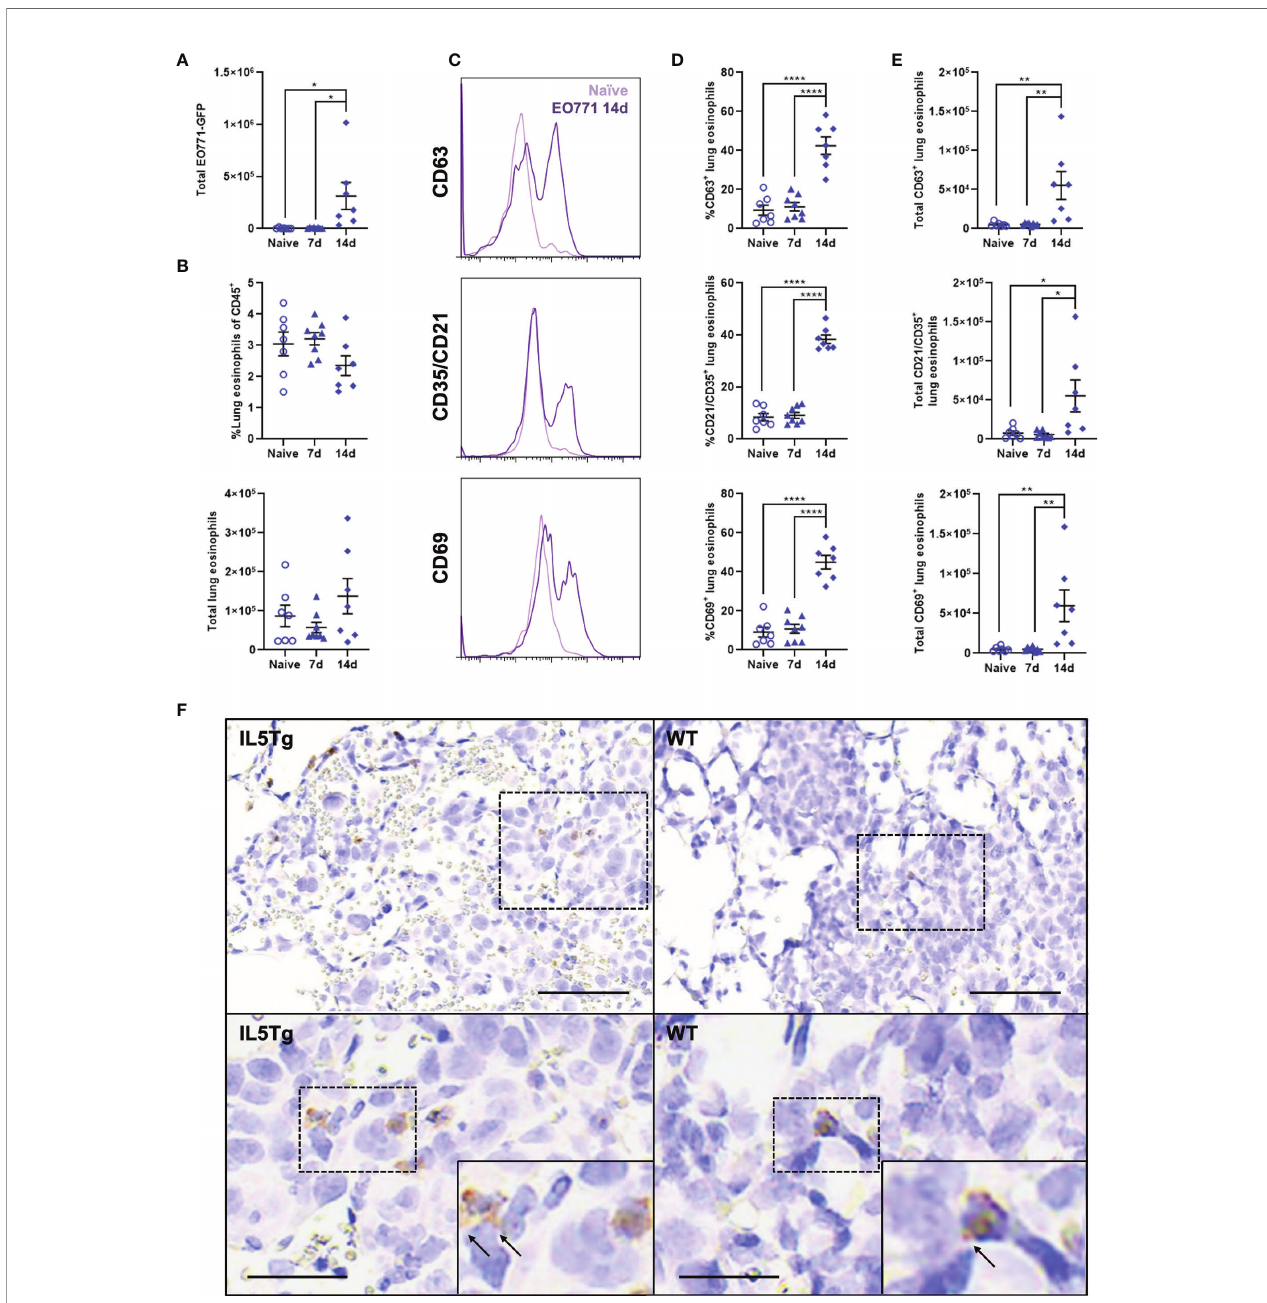
FIGURE 4 | Lung eosinophils become activated during pulmonary EO771 tumor growth. (A) Total number of EO771-GFP cells in the lungs of WT mice 7 days and 14 days following i.v. injection of EO771-GFP cells. (B) Frequency and total number of lung eosinophils in naïve WT mice and WT mice injected i.v. with EO771-GFP cells 7 days and 14 days post-injection. (C) Representative histogram overlays of eosinophil expression of CD63, CD35/CD21, and CD69 in naïve WT mice and WT mice 14 days after i.v. injection with EO771-GFP cells. (D) Frequency and (E) total number of eosinophils expressing CD63, CD35/CD21, and CD69 in naïve WT mice and mice either 7 days or 14 days post-i.v. injection of EO771-GFP cells. (F) Representative lung IHC of WT and IL5Tg mice 14 days after i.v. injection of EO771-GFP cells. Sections were stained with anti- mMBP and anti-GFP to visualize eosinophils (brown) and EO771-GFP tumor cells (pink). Black arrows indicate extracellular MBP staining. Scale bar = 100 m m (upper images) and 50 m m (lower images). Data points are individual mice with mean ± SEM of 7-8 mice per group. *p < 0.05; **p < 0.01; ****p <